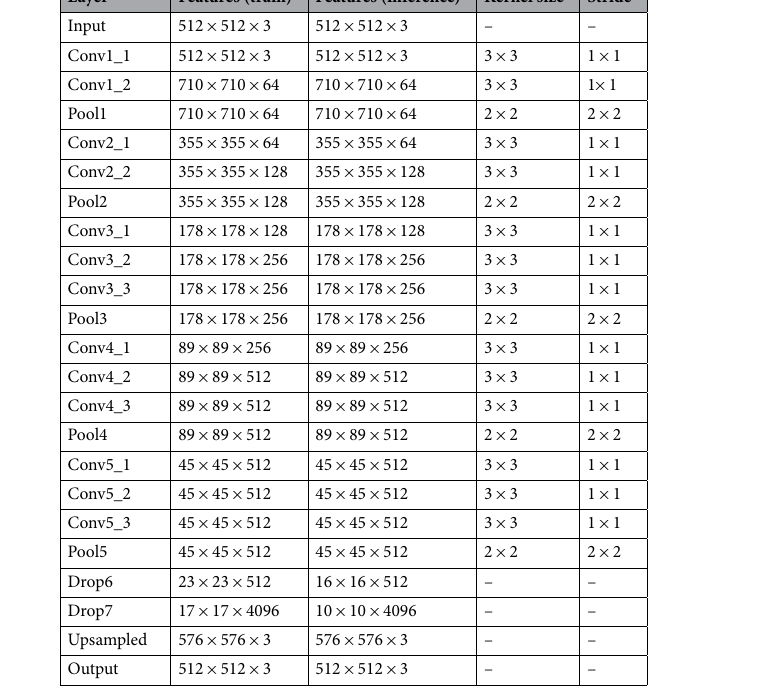
Table 6. The architecture of the proposed deep learning